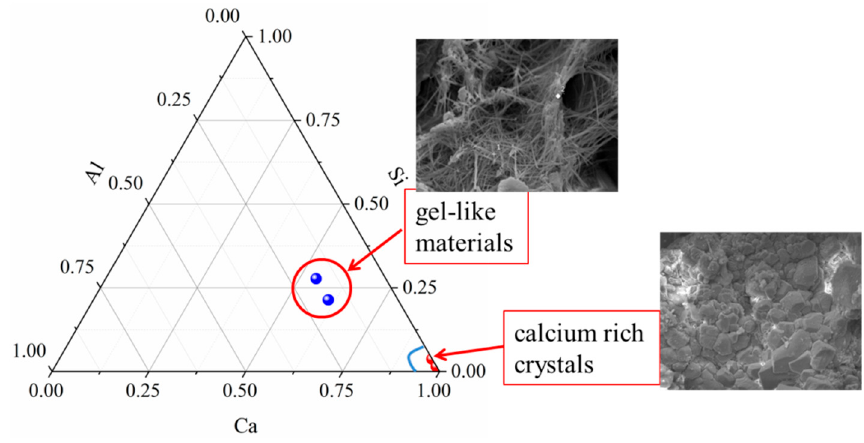
Figure 17. Atomic ratio plot of the self-healing products.